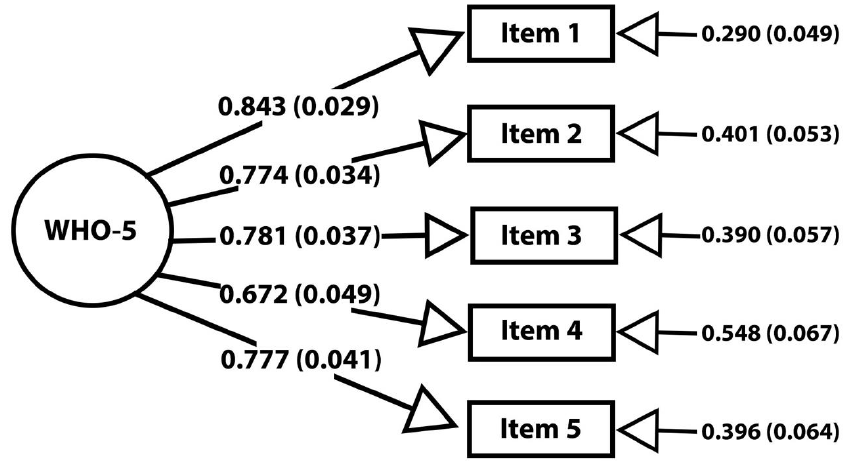
Figure 1. Structural equation model (SEM) for the WHO-5. Numbers on the arrow pointing from latent variable (WHO-5) to the items are the standardized factor loadings (with standard errors). The numbers pointing to the items from the right are the residual variance (with standard errors).